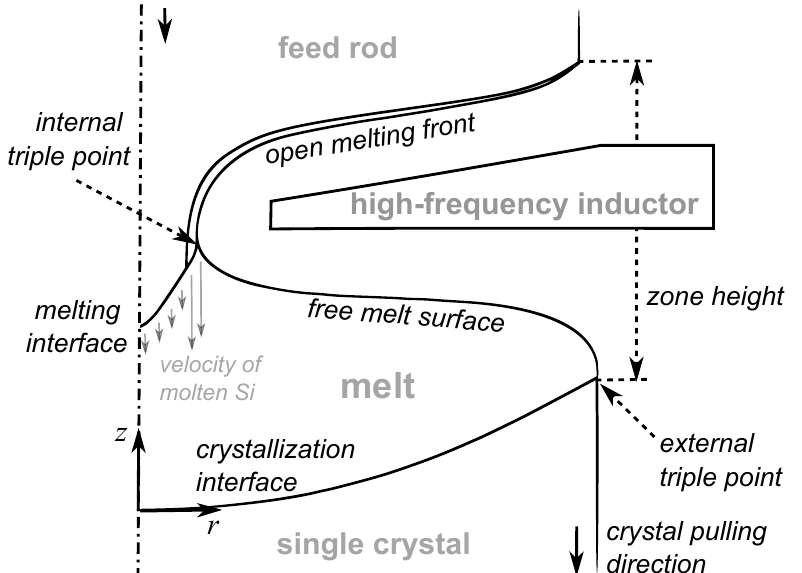
Figure 1. Axially symmetrical scheme of the FZ method, with designations of the most important parts and the used coordinate system.